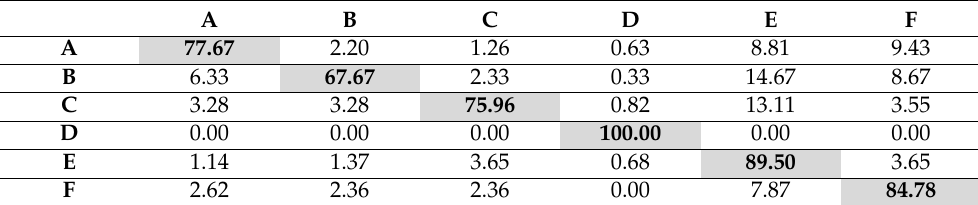
Table 10. Confusion matrix (%) of 3D-DIDGP28 on Set 2 using Random Forest classifier. A